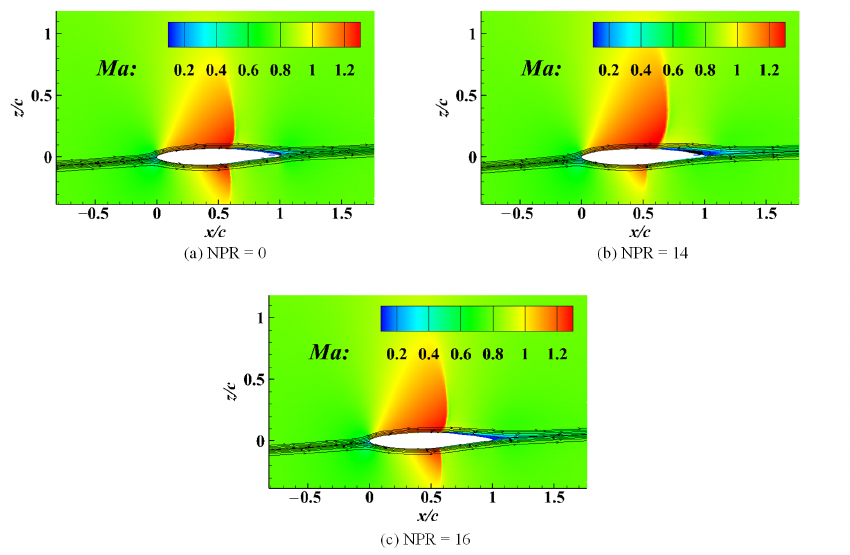
Figure 21. Effects of the CC jet on the streamline shapes with increasing NPR for Ma = 0.8 at α = 3 ◦